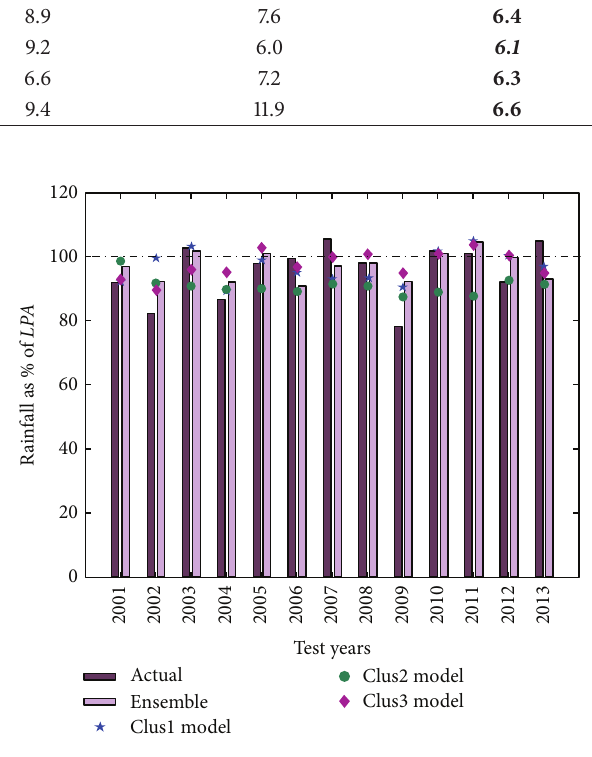
Figure 6: Performance of forecasts by proposed fuzzy clustering- based ensemble model and its respective three clusters models by GRNN for PredSet3 . The deep and light purple bars represent the actual and predicted ISMR in terms of percent of LPA . The symbols represent forecasts given by individual cluster models. The results are shown for test period